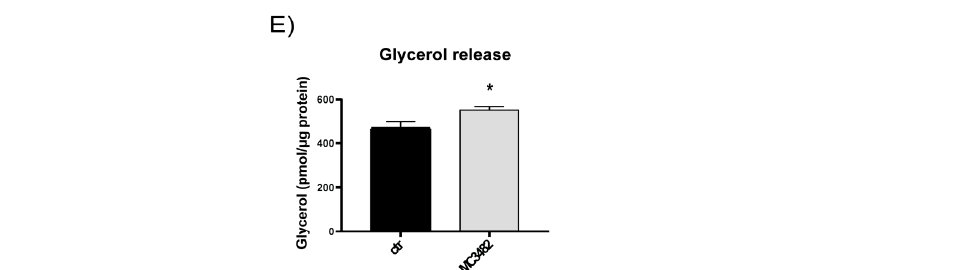
Figure 5. SIRT5 inhibition affects intracellular lipid droplet size and lipolysis. ( A ) Representative TEM images of intracellular lipid droplets (LDs) in 3T3-L1 adipocytes at day 10, treated or not with MC3482. Scale bars = 2 µ m. ( B ) Confocal microscopy analysis of LDs (stained by using Oil Red O) and adipose triglyceride lipase (ATGL). Nuclei were stained with DAPI (blue). Scale bars = 20 µ m. ( C ) Evaluation of Oil Red O staining intensity. ( D ) Western blot analysis of lipolytic proteins at day 7 of 3T3-L1 cells differentiation upon treatment with MC3482 or vehicle. ( E ) Effects of MC3482 treatment on glycerol release measured in 3T3-L1 cells culture media. Supernatants of isoproterenol-stimulated 3T3-L1 cells (day 10 of differentiation) were collected and free glycerol release was measured. Values are expressed as means ± SEM of 3 independent experiments. * p < 0.05 vs. untreated control cells